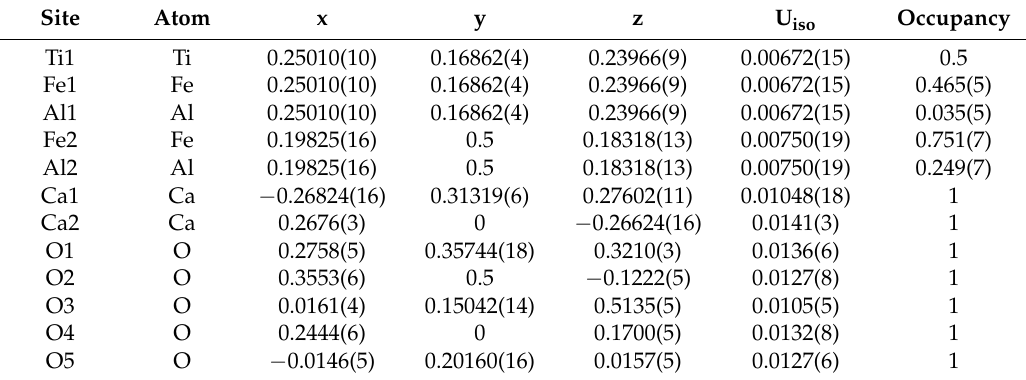
Table 6. Atom coordinates (x,y,z), occupancies and equivalent isotropic displacement parameters (U iso , Å 2 ) for sharyginite.